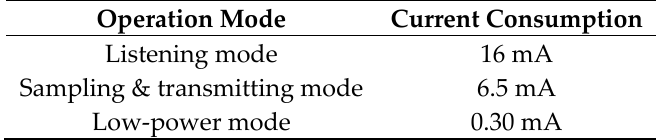
Table 1. Current consumption in the different operation modes, at a supply voltage of 3.0 V.